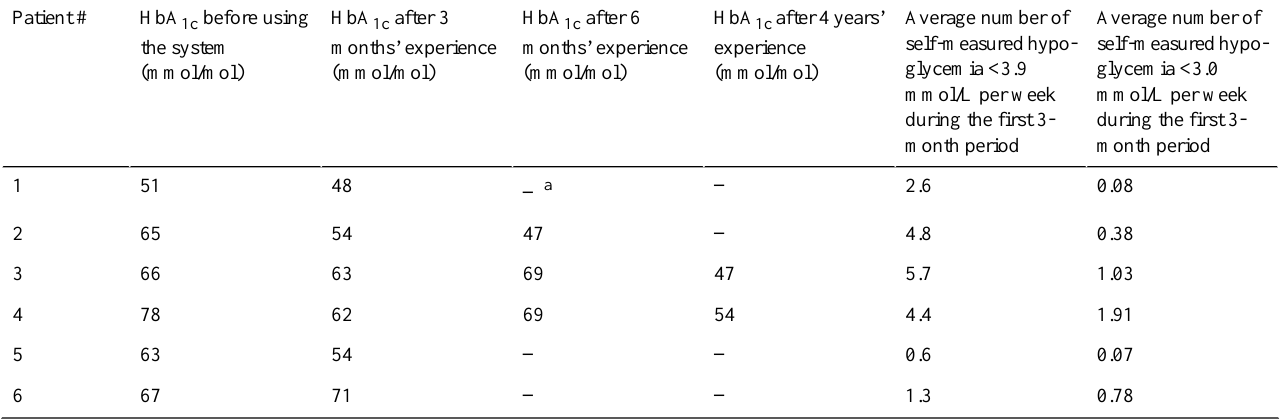
Table 3. Glycated hemoglobin (HbA 1c ) values and frequency of